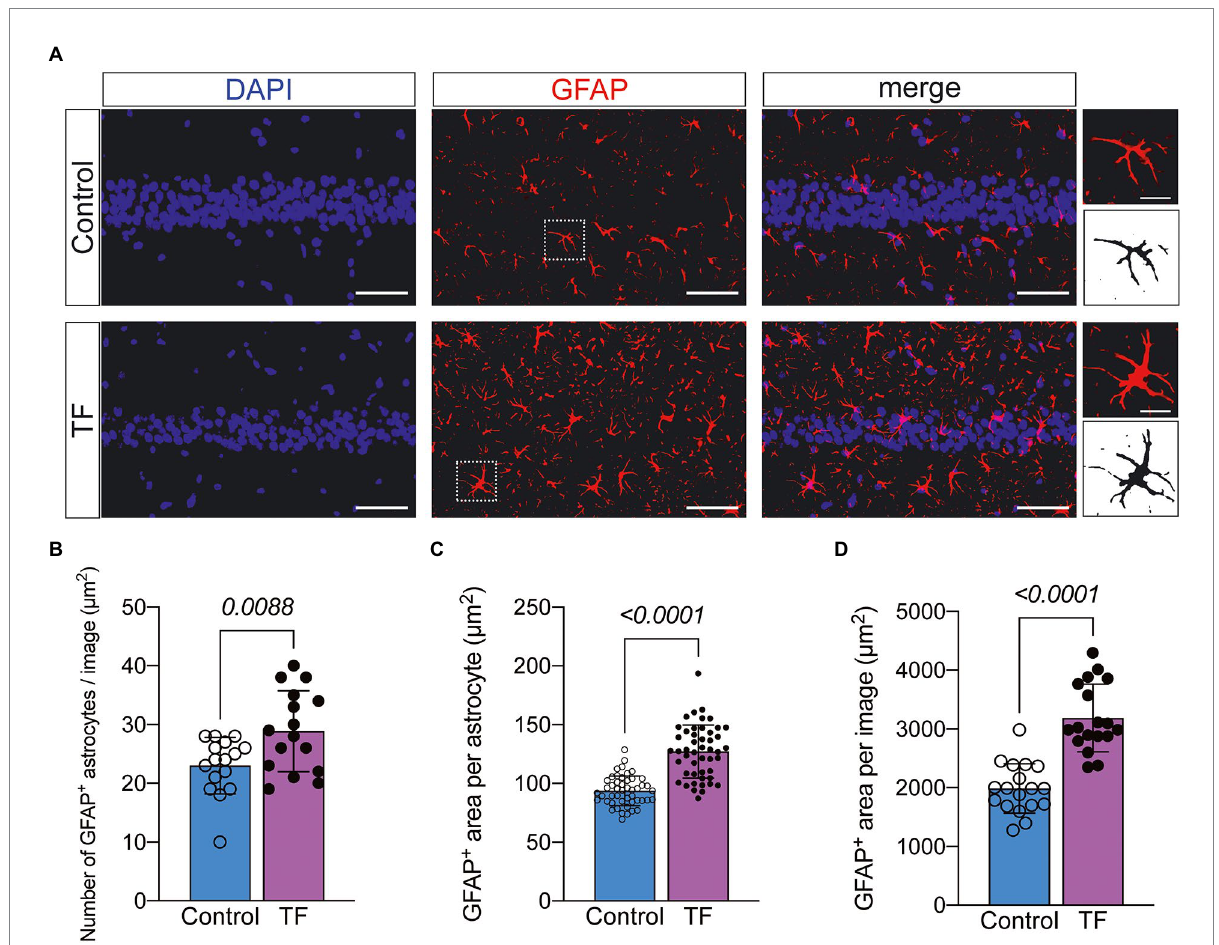
FIGURE 4 Immunofluorescence staining of astrocytes on day 10 after fracture surgery. (A) GFAP-labeled astrocytes in the hippocampal CA1 region ( n = 4). Scale bar = 50 μ m or 10 μ m. (B–D) Quantitative analysis of GFAP + astrocytes. Data were expressed as mean ± SD and analyzed using two-tailed unpaired t -test. The p -values are shown in the